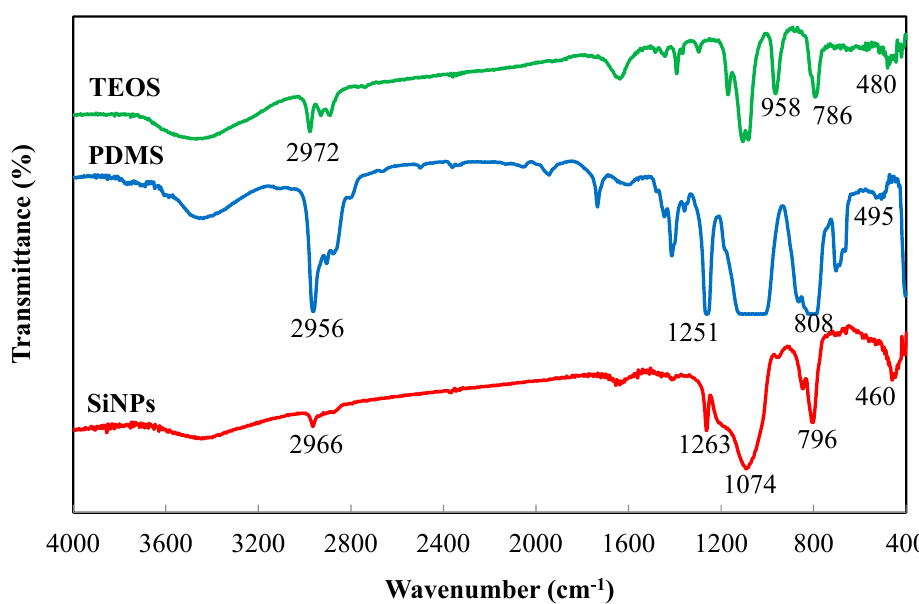
Figure 7. FTIR spectra of TEOS, PDMS, and SiNPs.